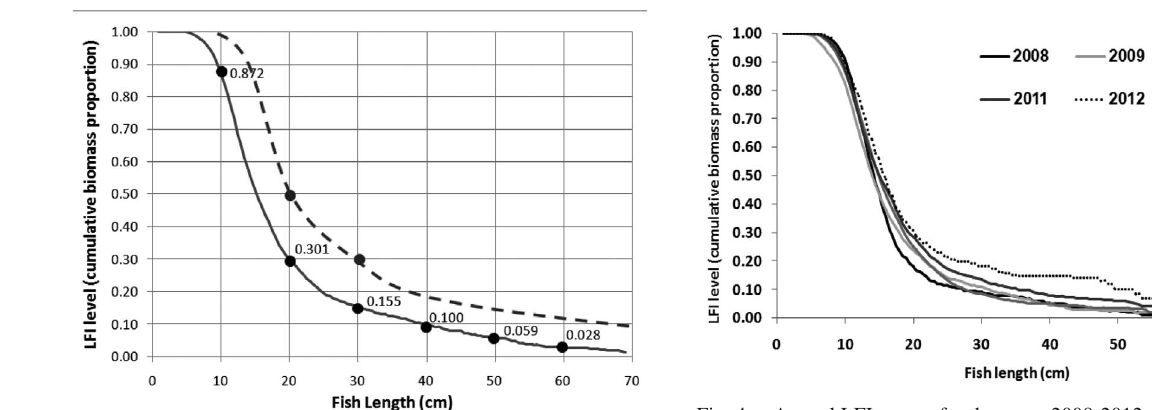
Fig. 4. – Annual LFI curves for the years 2008-2012. Note that sur- veys began in the autumn of 2008 and ended in the spring of 2012. Fig. 2. – The LFI curve for the 2008-2012 surveys. Black dots mark LFI levels at 10-60 cm, and a theoretical catch curve, passing through the desired LFI =0.5 and LFI =0.3 values (dashed line). 20 30